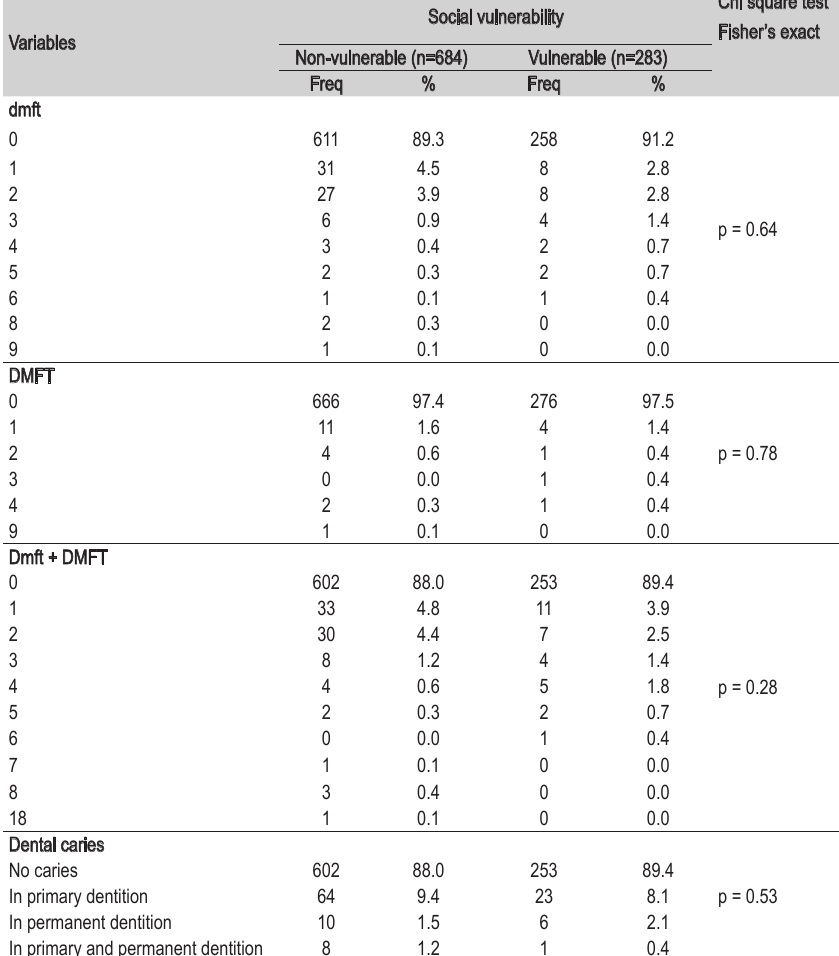
Table 4 - Social Vulnerability, dmft, DMFT and presence of